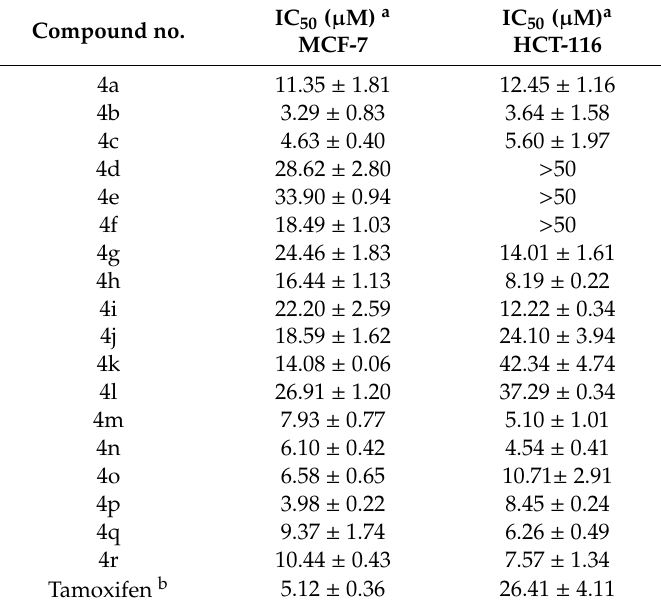
Table 1. Anti-proliferative e ff ects of 4a – q series compounds in MCF-7 and HCT-116 cells. Compound no.